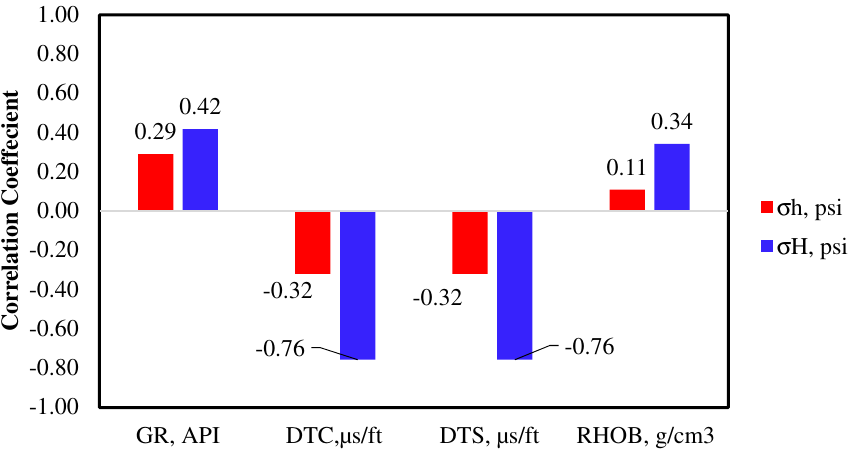
Figure 3. Correlation coefficient between the conventional logging parameters and the minimum and maximum ( σ h and σ H ) horizontal